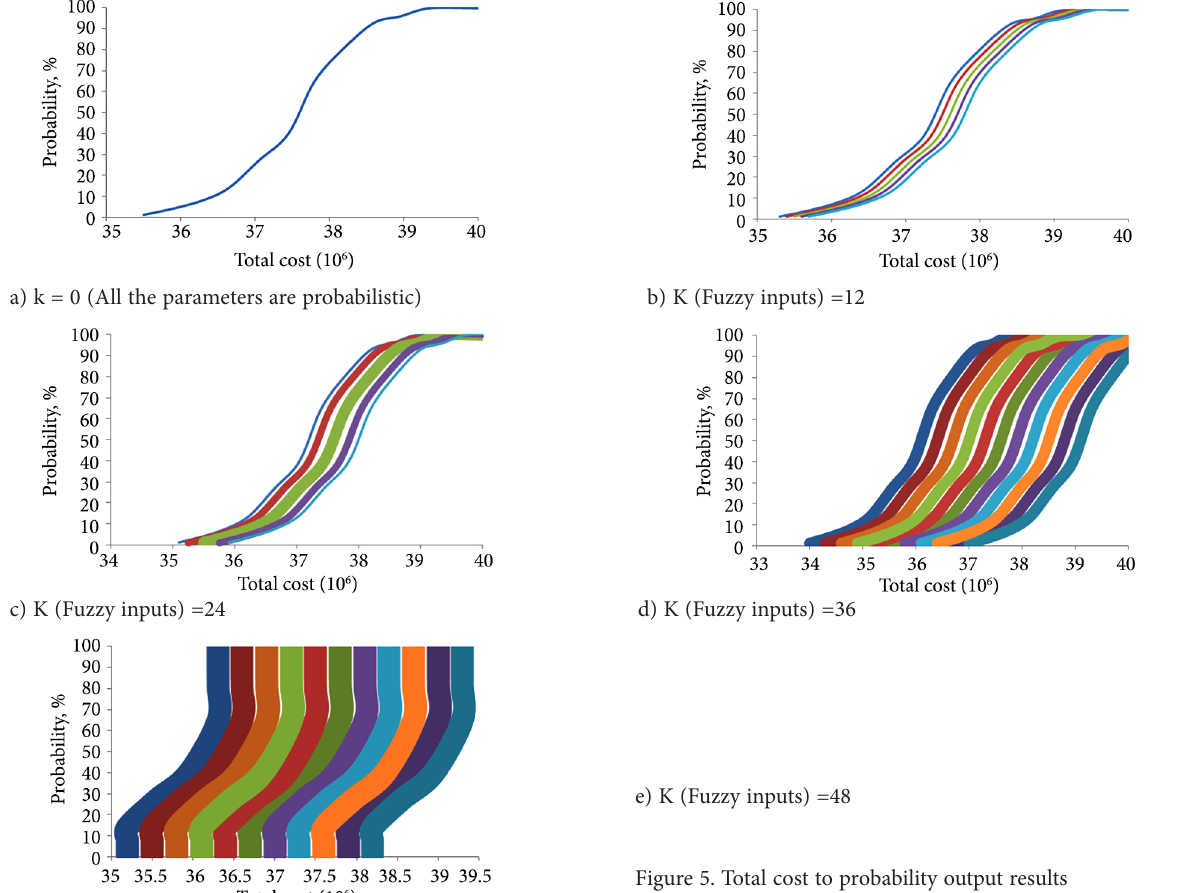
Figure 5. Total cost to probability